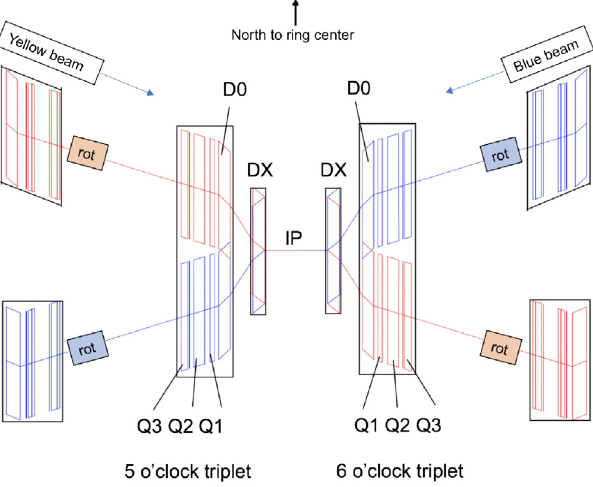
FIG. 24. Rotator pairs at IP6 in RHIC.